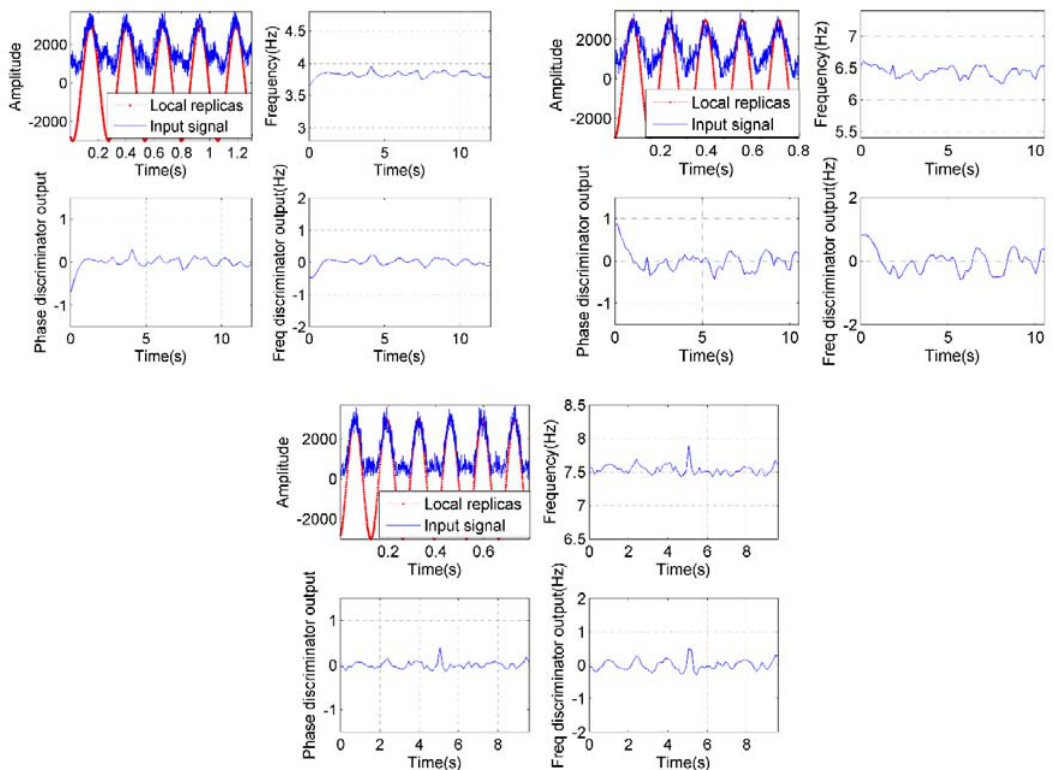
Figure 22. Roll modulation signals tracking results of different spin rates of 3.8 r/s (top left group), 6.4 r/s (top right group), and 7.5 r/s (bottom group).